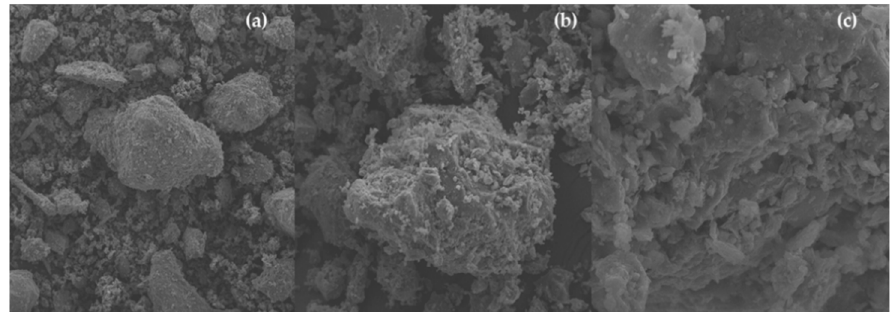
Figure 6. SEM of Si–Al ash pellets [MAG: 338× ( a ); MAG: 1.67k× ( b ); MAG: 5.00k× ( c )].